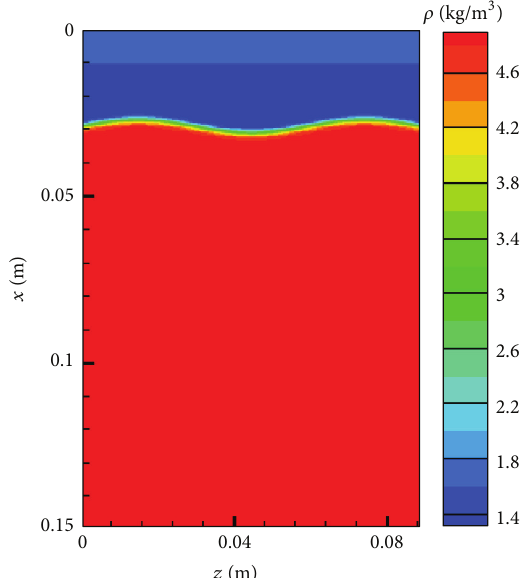
Figure 8: Instantaneous contours of initial density across centerline y -direction ( 𝑌 = 0 ) at 𝑡 = 0